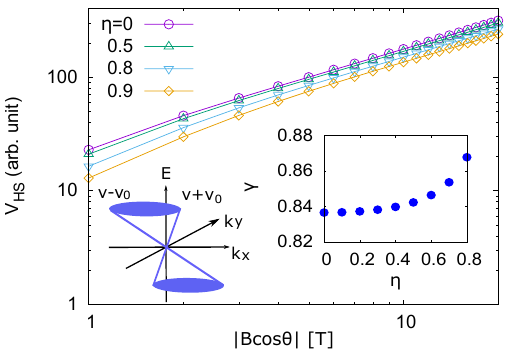
Figure 1. Theoretical results on | B cos θ | dependences of V HS for η = 0 (circle), 0.5 (triangle), 0.8 (inverted triangle), and 0.9 (diamond). The right inset shows the η dependence of γ . The left inset indicates the tilted Dirac cone, where v and v 0 are cone velocity and tilt velocity,